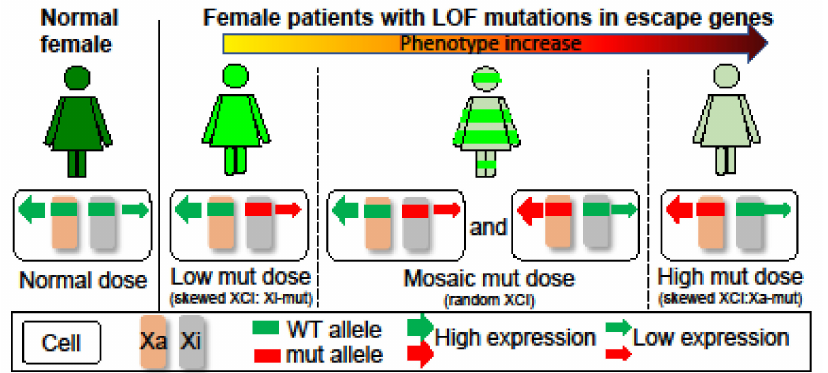
Figure 3. Impact of XCI on X-linked disorders due to heterozygous LOF mutations in escape genes. Normal females have a dose of products from wild-type (WT) alleles on the Xa and Xi. Patients with skewed XCI have a differential dose reduction depending on which X carries the mutation (mut). This would lead to a mild phenotype in patients with Xi-mut, whereas a most severe phenotype in patients with Xa-mut. Thus, skewed XCI towards the mutant allele could alleviate the phenotype. In contrast, patients with random XCI have a mosaic reduction due to mixtures of cells expressing Xa- or Xi-mut, leading to a phenotype between patients with Xi-mut or Xa-mut. In addition, XCI mosaicism could cause cellular interference at tissue levels and lead to a different phenotype, as is the case for PCDH19 clustering